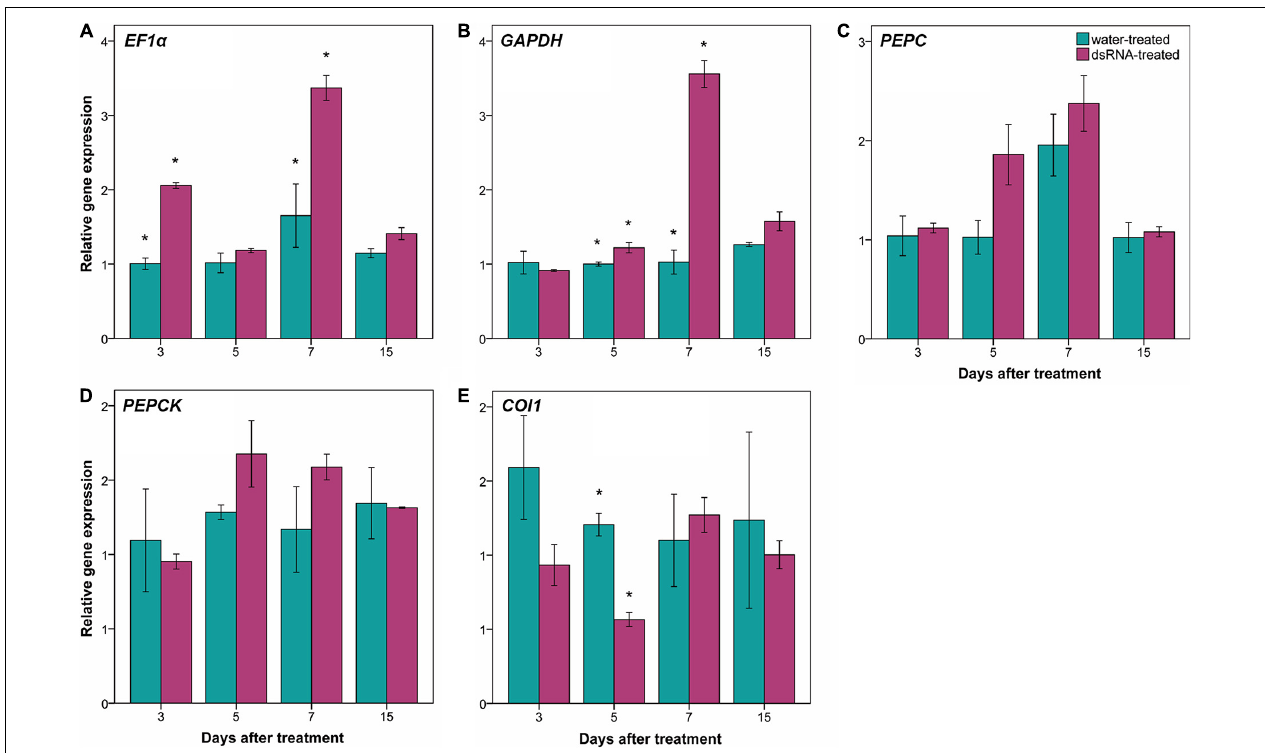
FIGURE 6 | Effect of dsRNA treatment on EF1 α [elongation factor 1 α ; (A) ], GAPHD (glyceraldehyde-3-phosphate dehydrogenase; B), PEPC [phosphoenolpyruvate carboxylases; (C) ], PEPCK [PEP carboxykinases; (D) ], and COI1 [coronatine insensitive 1; (E) ] gene expression at 3, 5, 7, and 15 days after treatment (dat) on Pinot noir plants grafted onto SO4. Gene expression analysis determined based on the 2 − (cid:49)(cid:49) Ct method. Bars represent standard errors. Asterisks indicate statistically significant differences among the dsRNA- and water-treated conditions at each time point (* p value =